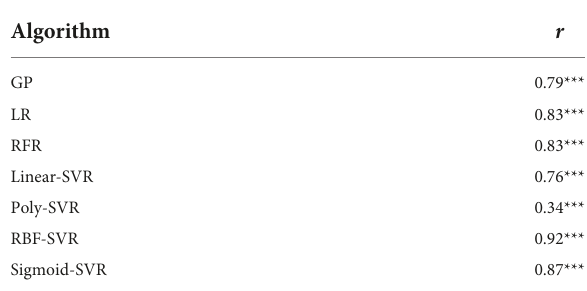
TABLE 5 The odd-even split reliability of the model.